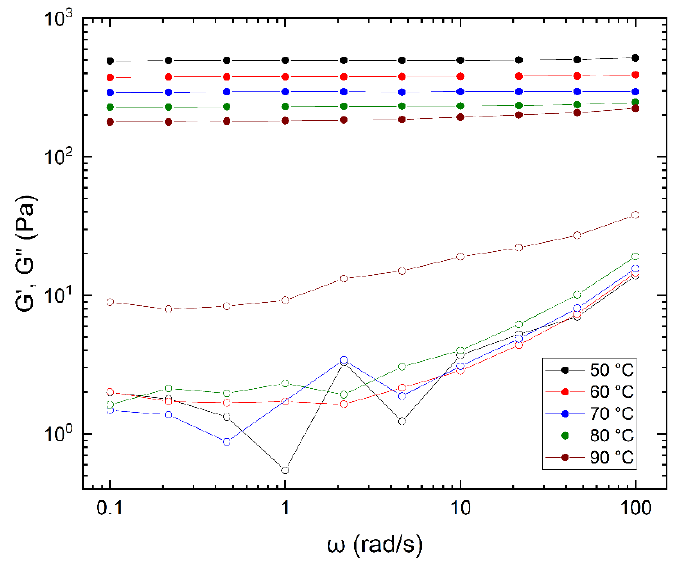
Figure 4. Frequency sweeps of the system of N- furfuryl chitosan 1 wt.% (21% degree of substitution) in 2% acetic acid and PEG(mal) 2 -7500 with R = 0.25 prepared at 50, 60, 70, 80, and 90 °C, as indicated in the figure. All the measurements were conducted at 25 °C and γ = 2.5 %. G ’, closed symbols, and G ’’, open symbols.